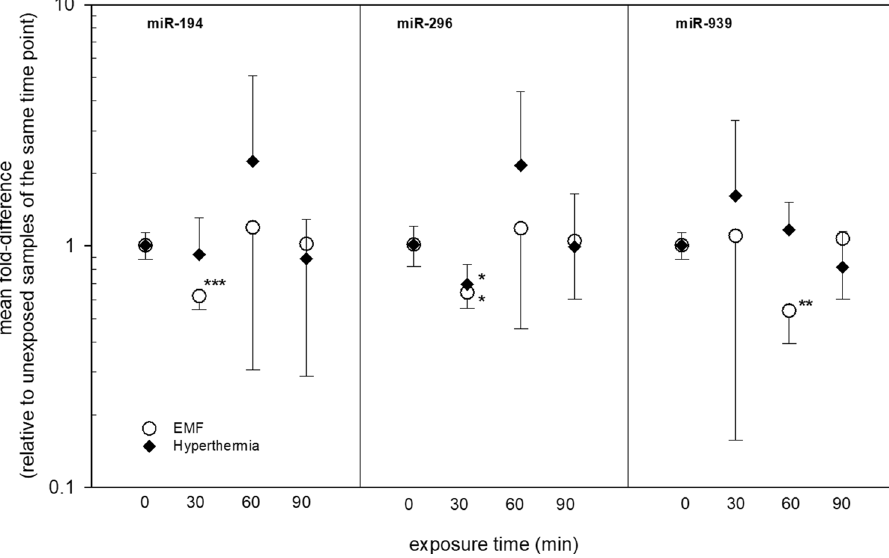
Figure 2. Provides mean fold-differences in miRNA gene expression of three miRNAs after EMF or hyperthermia exposure over the exposure time. Symbols represent mean fold-differences in gene expression and the error bars represent the SEM, n = 4–5. Asterisk reflects significance levels as follows: * p -value ≤ 0.05, ** p -value ≤ 0.01, *** p -value ≤ 0.001.